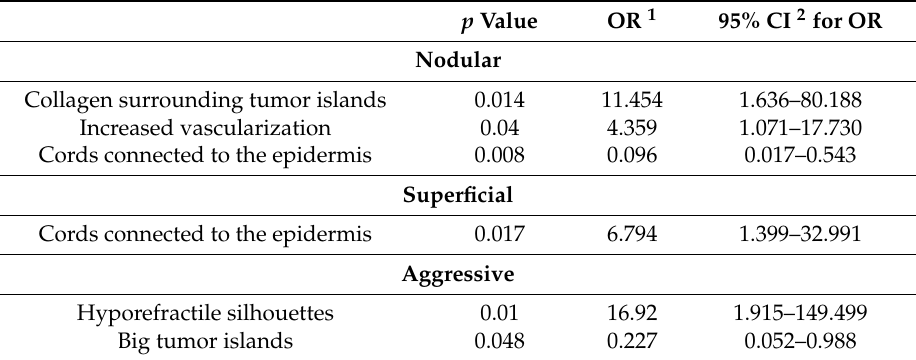
Table 3. Multivariate reflectance confocal microscopy criteria predictors for nodular, superficial, and aggressive subtypes of basal cell